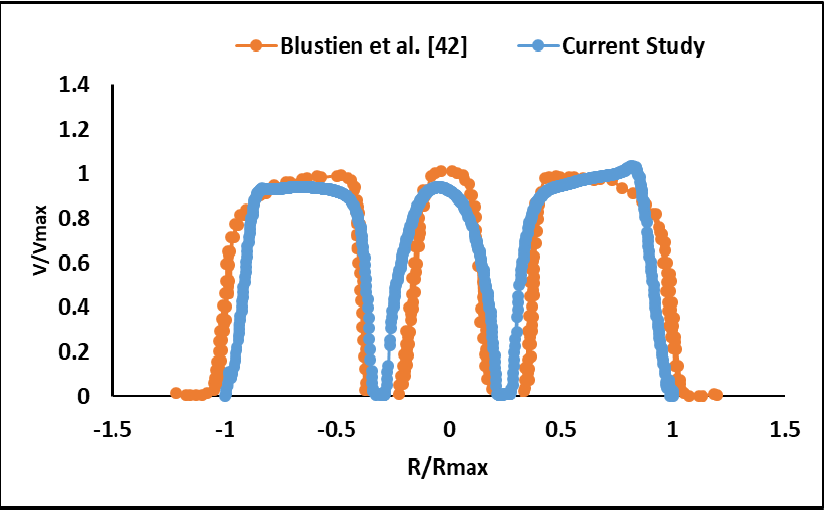
Figure 2. Comparison between normalized velocity of the current study and the study of Bluestein and co-authors around the peak systole. Velocity profile was measured downstream of the BMHV and near the trailing edges of the leaflets. (R/Rmax) is the normalized radius.